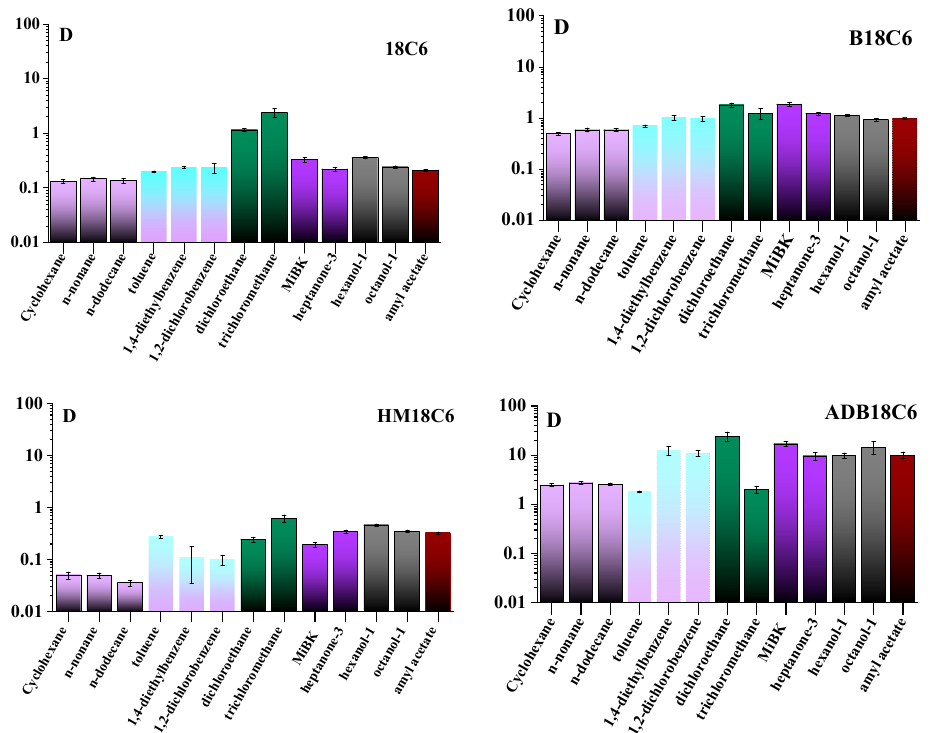
Figure 3. Distribution coefficients (D) of the studied LCEs between water and organic phases for 1 h of contact.